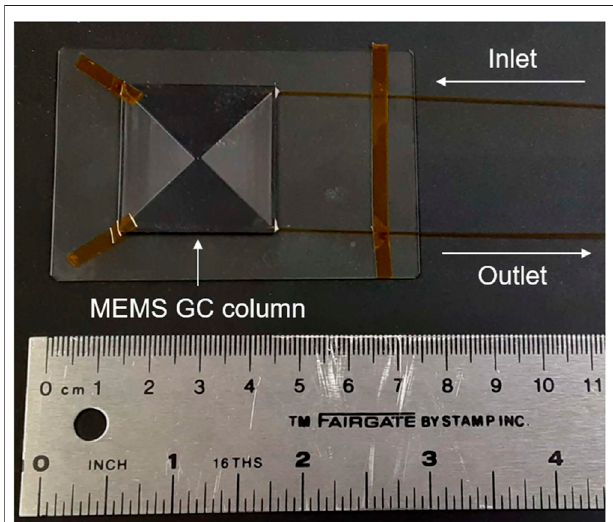
FIGURE1| Photographofthe5.5 mlengthMEMSGCcolumnwithinlet and outlet fused silica capillaries. The column footprint is approximately 3 cm × 3 cm, reducing the size versus MXT (metal clad) capillary